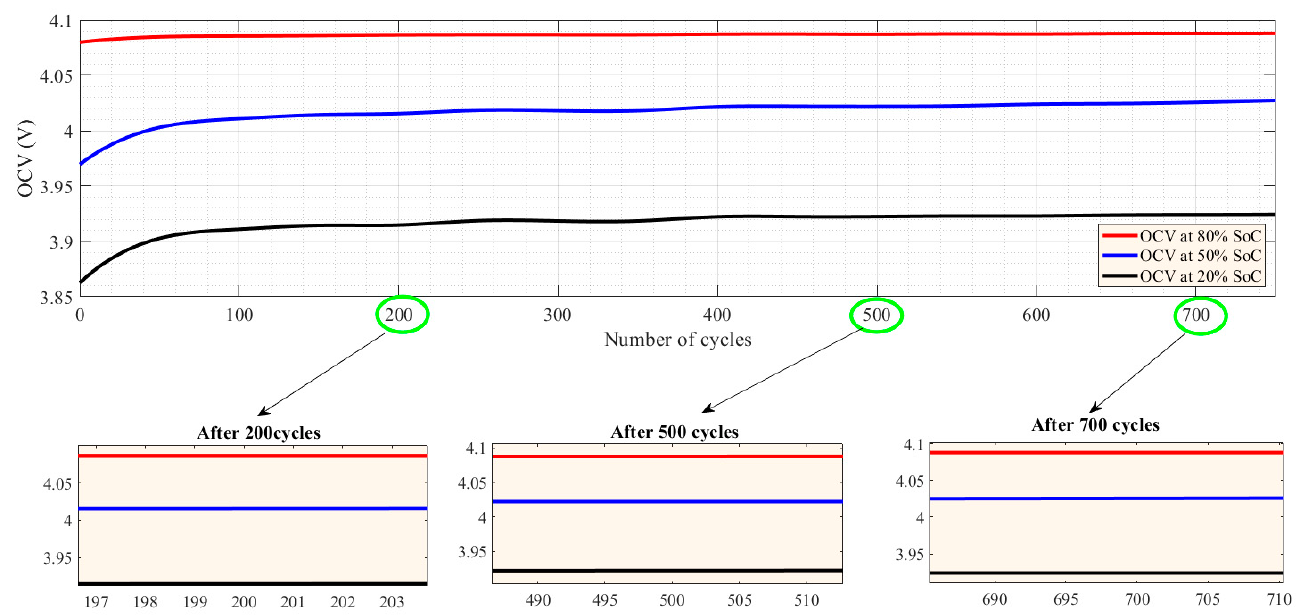
Figure 10. Comparison of the OCV pattern at 25 °C under C/2 charge and 1 C discharge test conditions.